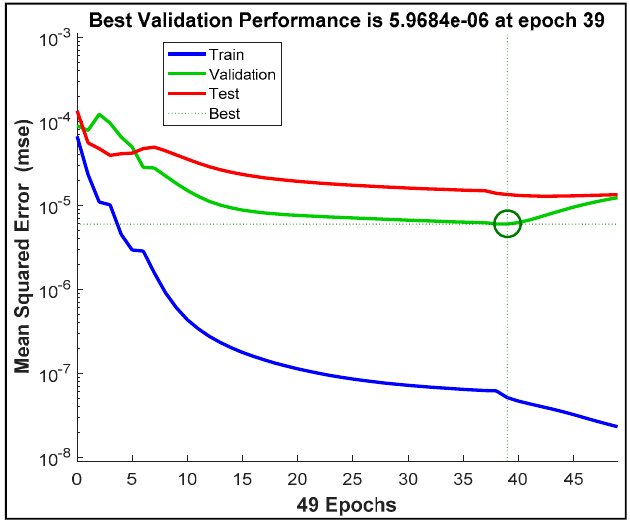
Figure 12. Best validation performance (for sample Y).